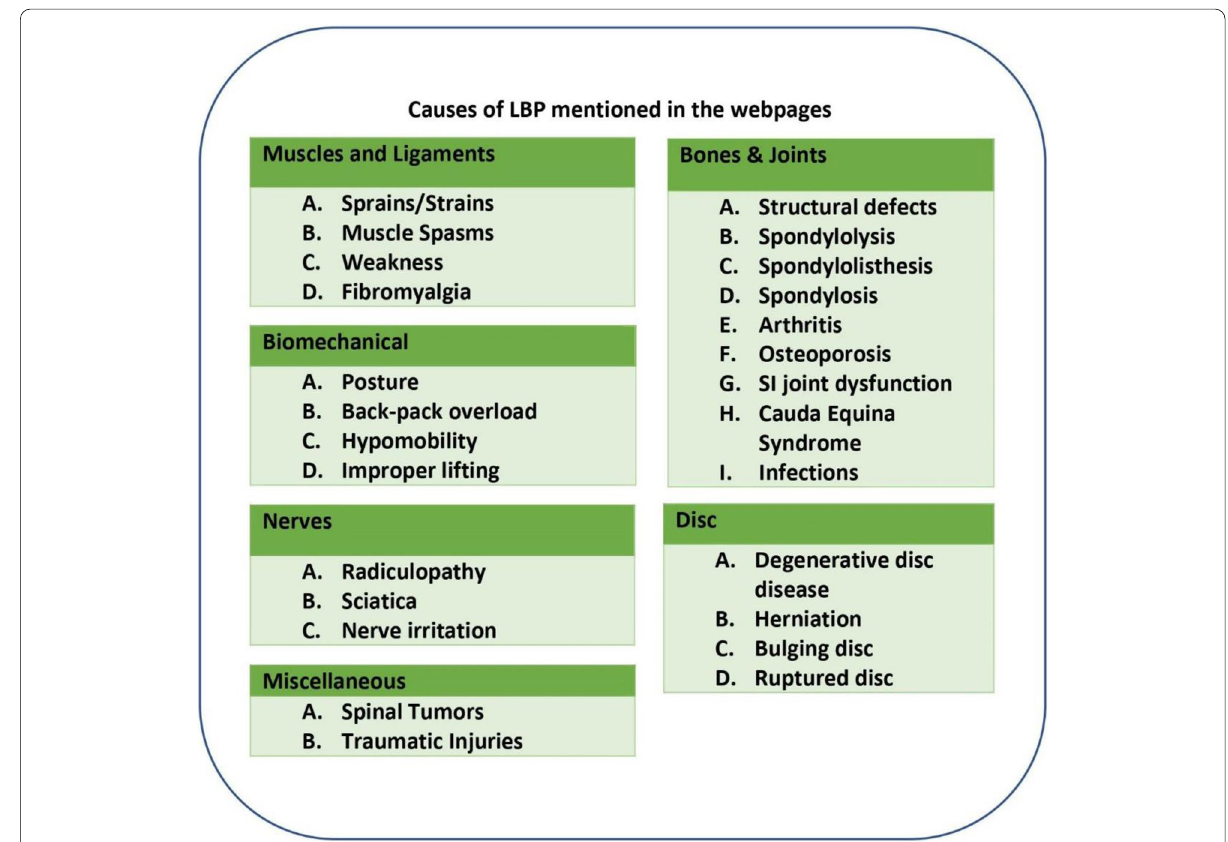
Fig. 4 Various causes of LBP categorized into different subsections based on